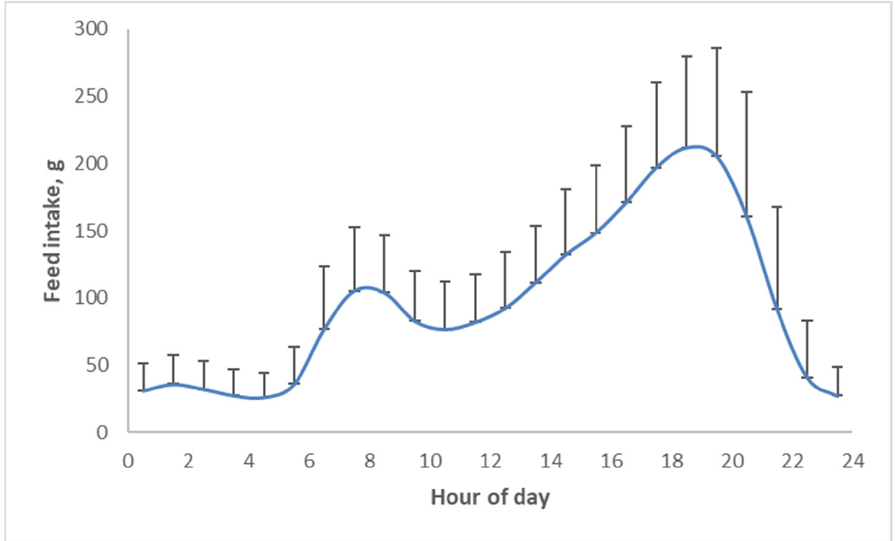
Figure 10. Circadian food intake pattern of pigs with continuous access to food [20].